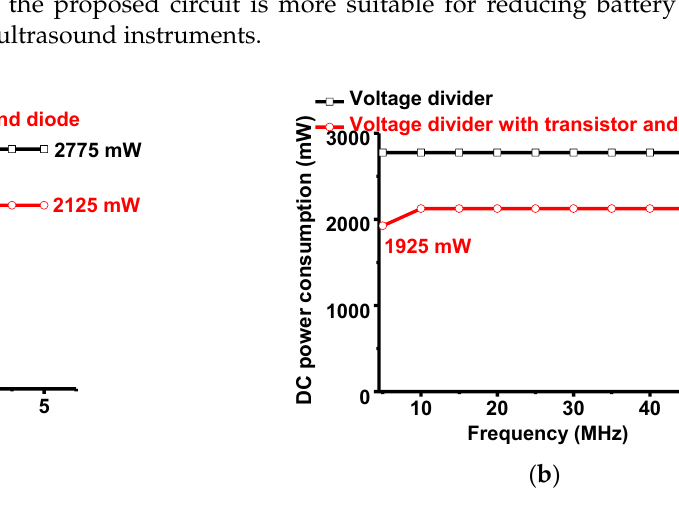
Figure 7. DC power consumption versus ( a ) input voltage and ( b ) frequency of the Class-C pulsed power amplifier with an independent voltage divider and with a voltage divider integrated with high-voltage transistor and switching diodes.